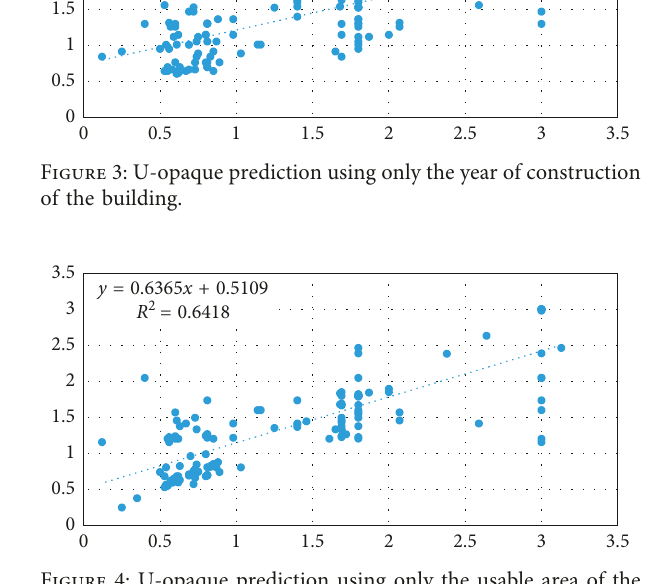
Figure 4: U-opaque prediction using only the usable area of the building.